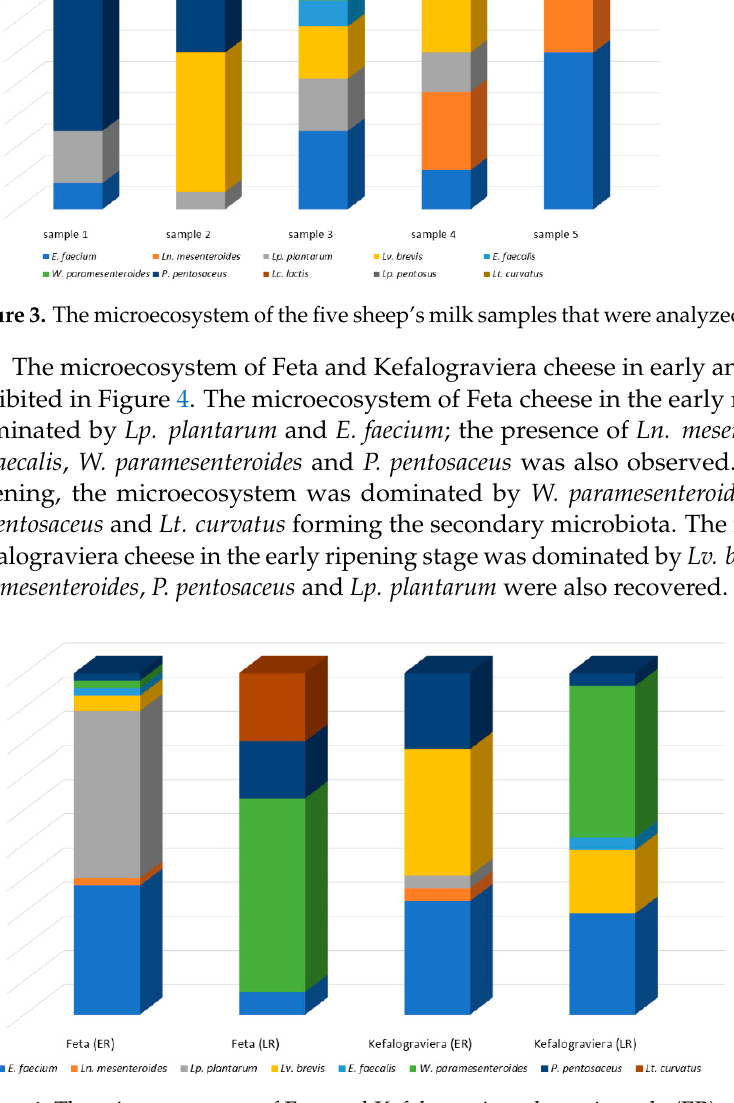
Figure 4. The microecosystem of Feta and Kefalograviera cheese in early (ER) and late (LT) ripening. As in the case of Feta cheese, in late ripening, the microecosystem composition was altered and dominated by W. paramesenteroides and E. faecium , with Lv. brevis , P. pento- saceus and E. faecalis being also present.